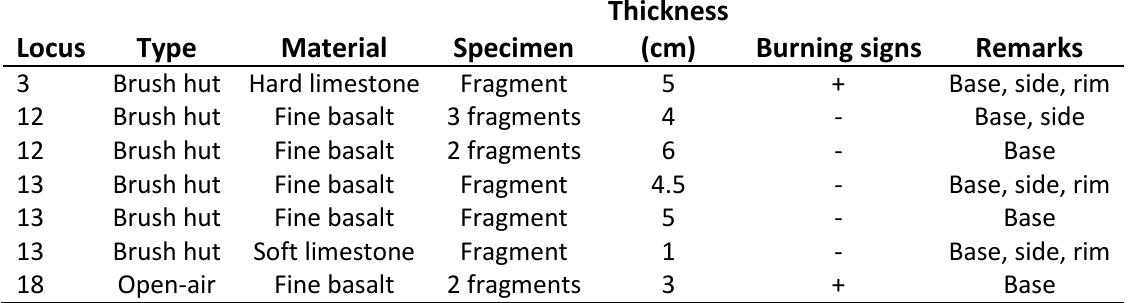
Table 2. Bowl fragments